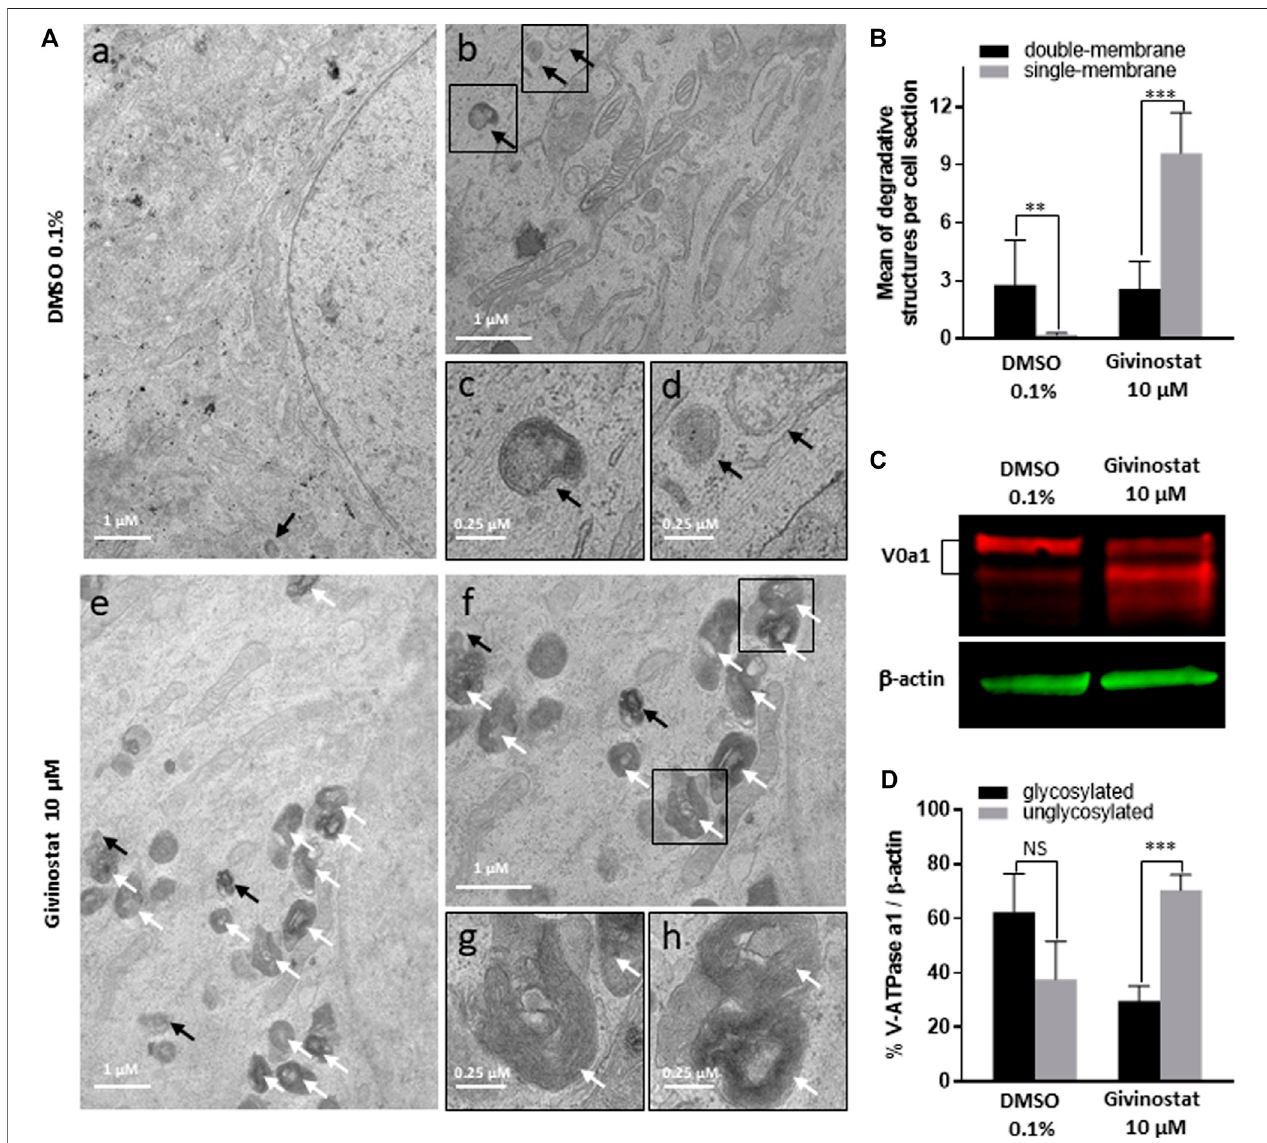
FIGURE 7 | Givinostat impairs autolysosomes degradation. (A) Transmission electron microscopy analysis of fi broblasts overexpressing R77C- α -SGmCh and treated with DMSO (0.1%) or givinostat (10 μ M) for 24 h. Few double membrane-bound organelles with a relative electron-lucent luminal content (black arrows) were found in DMSO and givinostat treated cells. Givinostat induced a large accumulation of single membrane-bound organelles with electron dense lumen (white arrows). Insetsaremagni fi cationsoftheboxedareas. (B) Quanti fi cationofdegradativestructuresidenti fi edaccordingtotheirmorphologydescribedin (A) .Dataaremean± SDofdegradativestructuresidenti fi edpercellsection( n =7);* p ≤ 0.05,*** p ≤ 0.001(Student ’ st-test). (C) Immunoblotanalysisofthev-ATPaseV0a1subunitexpression in fi broblasts treated with DMSO (0.1%) or givinostat (10 μ M) for 24 h β -actin was used to evaluate the loading. (D) Quanti fi cation of the glycosylated and the unglycosylated V0a1 subunit expression. Values are expressed as percentage of total V0a1 protein expression normalized to β -actin. Data are mean ± SD of three independent experiments; NS, non-signi fi cant, *** p ≤ 0.001 (Student ’ s t-test).